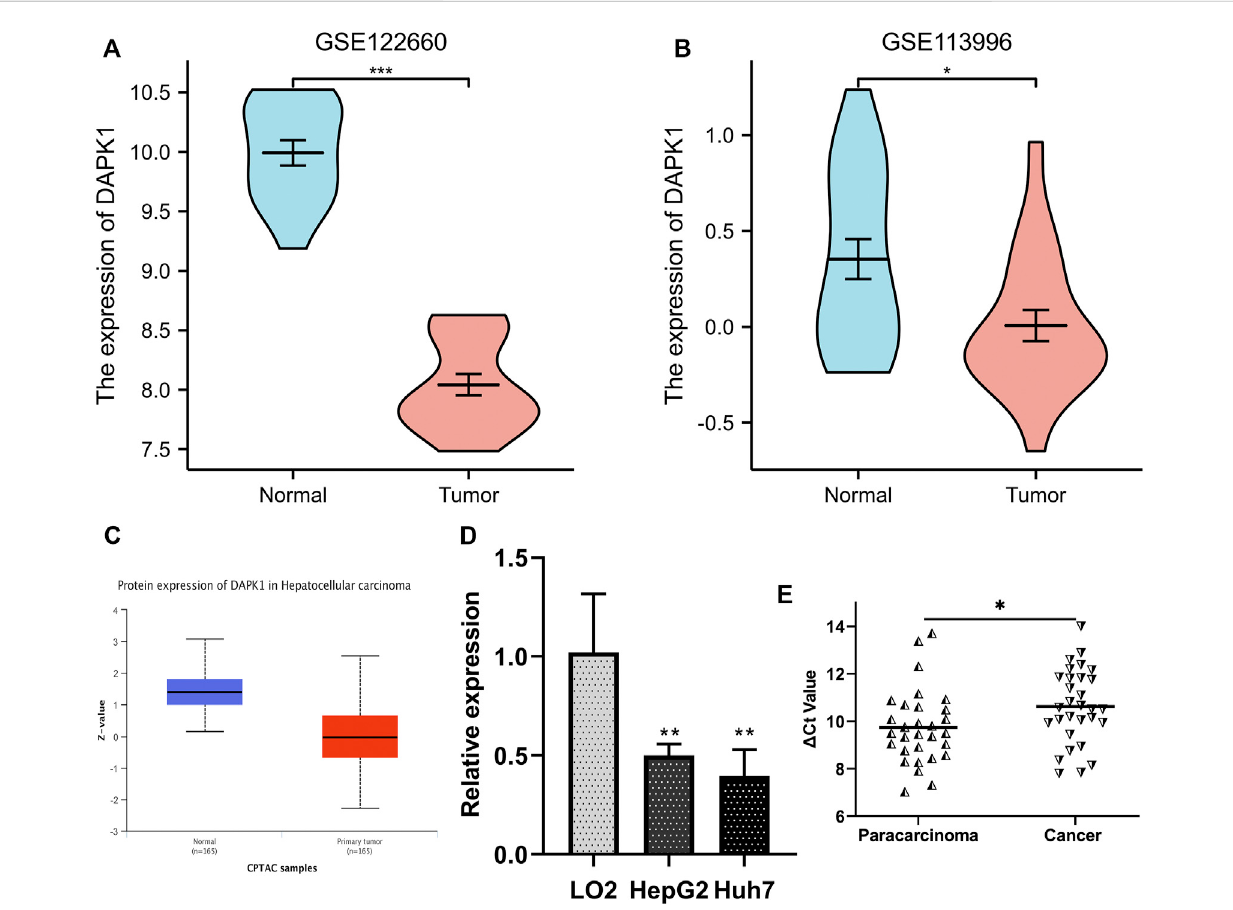
FIGURE 6 Validation of the differentially expression level of DAPK1 in GEO database. (A) DAPK1 was downregulated in HCC cells from GSE122660. (B) DAPK1 was downregulated in HCC tissues from GSE113996. (C) The protein level of DAPK1 was downregulated in UALCAN cohort. (D) DAPK1 was downregulated in HepG2, Huh7 cell compared to the LO2. (E) DAPK1 was downregulated in HCC tissues (* p < 0.05, ** p < 0.01, *** p <